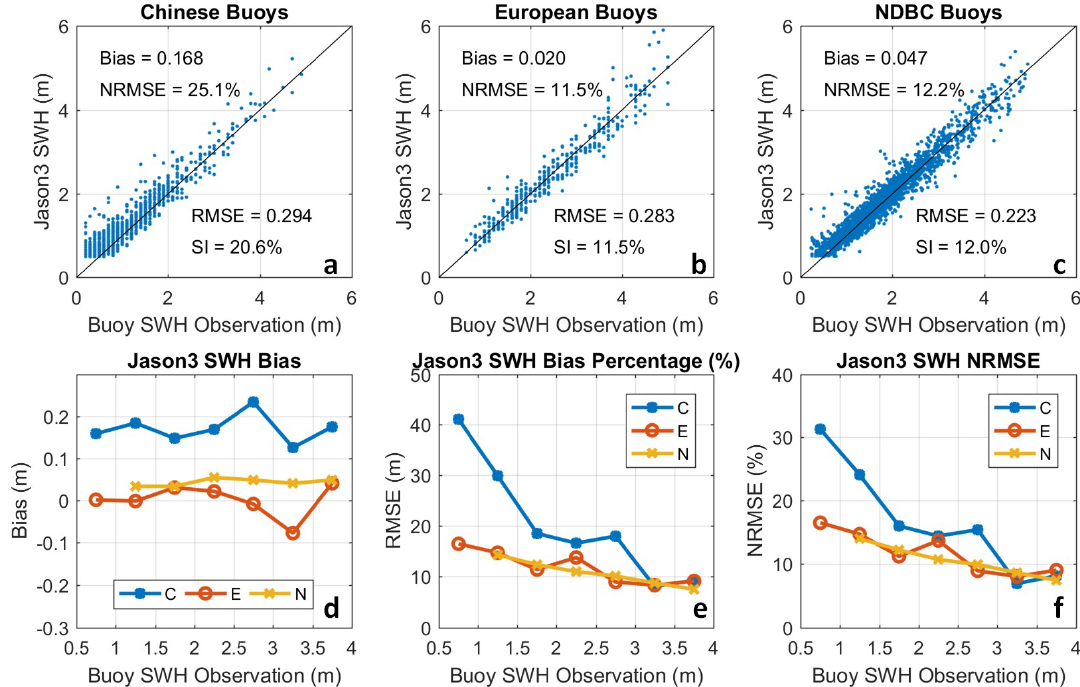
Figure 2. The validation of Jason-3 SWH against buoys from the three buoy networks. ( a – c ) indicate the scatters and the statistical parameters; ( d ) indicates the bias distribution with the SWH value; ( e ) indicates the percentage of bias in each SWH level; ( f ) shows the NRMSE distribution with the significant wave height (SWH) value. Among ( d – f ), the legends C, E and N represent the Chinese network, European network and theNDBC network, respectively.